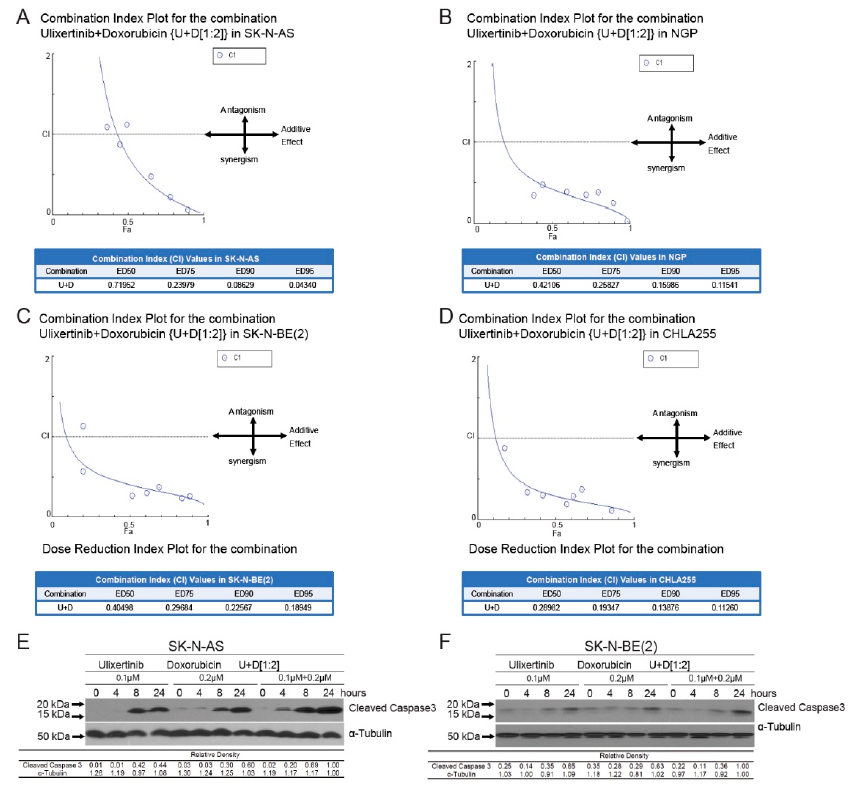
Figure 4. Ulixertinib enhances the anti-tumor activity of doxorubicin in human neuroblastoma cells. ( A – D ) CI plots for SK-N-AS, NGP, CHLA255, and SK-N-BE (2). Four NB cell lines, including SK-N-AS ( A ), NGP ( B ), SK-N-BE(2) ( C ), and CHLA255 ( D ) cells, were treated with ulixertinib, doxorubicin, and their combinations at a ratio of 1:2 respectively, for 72 h. The combination index (CI) values were calculated by the Chou–Talalay method for drug interactions using Compusyn software. Val- ues of CI < 1, =1, and >1 indicate synergism, additive effects, and antagonism, respectively. The obtained CI values for the combination of ulixertinib and doxorubicin at different effective doses (ED50, ED75, ED90, and ED95). ( E , F ) SK-N-AS ( E ) and SK-N-BE(2) ( F ) cells were treated with either doxorubicin alone, ulixertinib alone, or their combinations for 4 h, 8 h, and 24 h. Then the whole- cell lysates were subjected to SDS-PAGE and immunoblotted with the cleaved-caspase 3 antibody. α -tubulin was used as a loading control in all samples. Gel densitometrical analysis was performed using ImageJ software (https://imagej.nih.gov/ij/index.html, accessed on 25 October 2022).